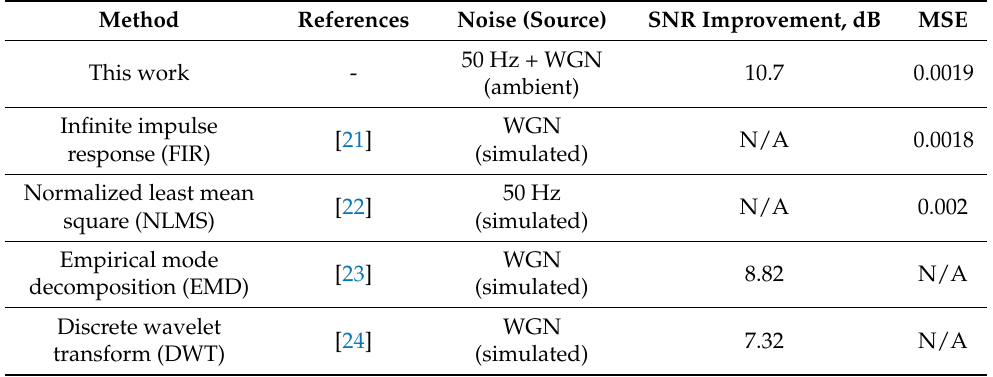
Table 1. Comparison of different filtering methods for MIT-BIH database record